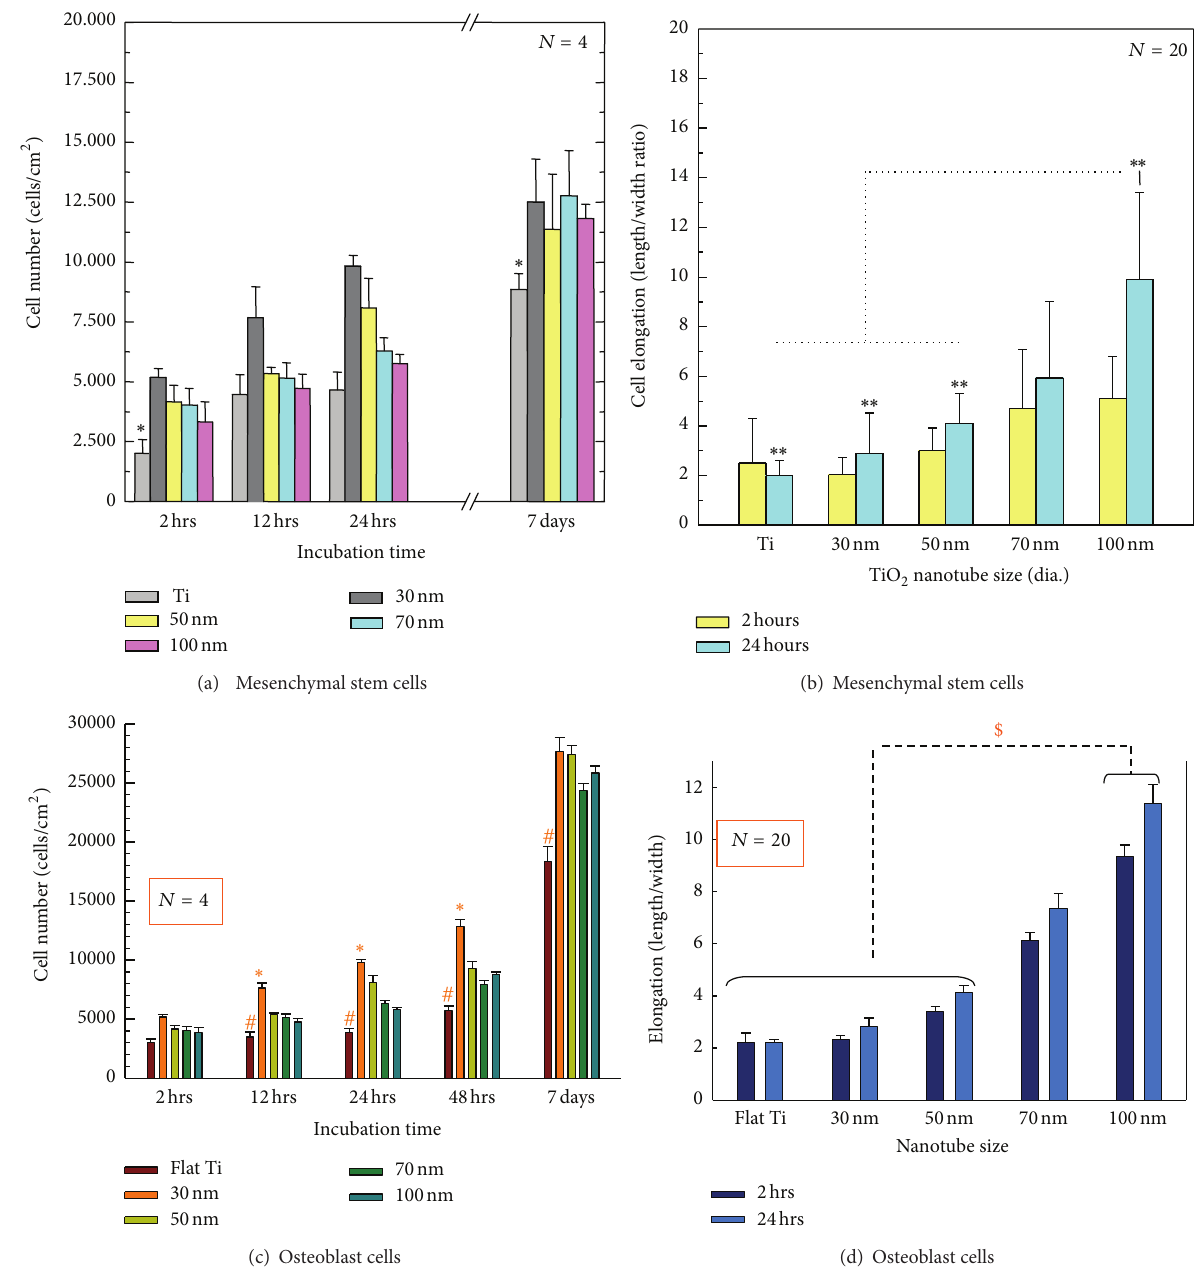
Figure 4: Comparative graphs showing the influence of nanotube diameter on cell number and elongation at early incubation time points. MSC cell number versus incubation time (a) and MSC elongation (length to width ratio) as a function of nanotube diameter at 2 and 24 h (b). Osteoblast cell number versus incubation time on each substrate (c) and osteoblast cell elongation as a function of nanotube diameter at 2 and 24 h